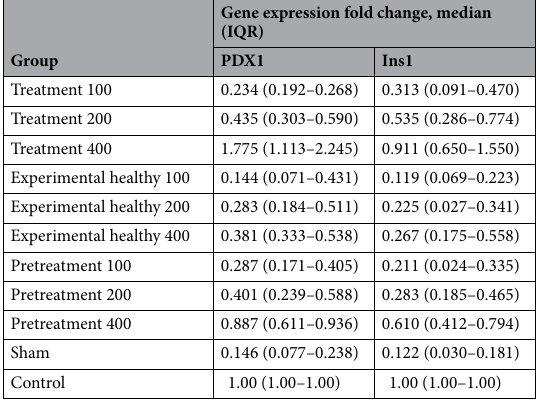
Table 1. PDX1 and Ins1 gene expression in the studied